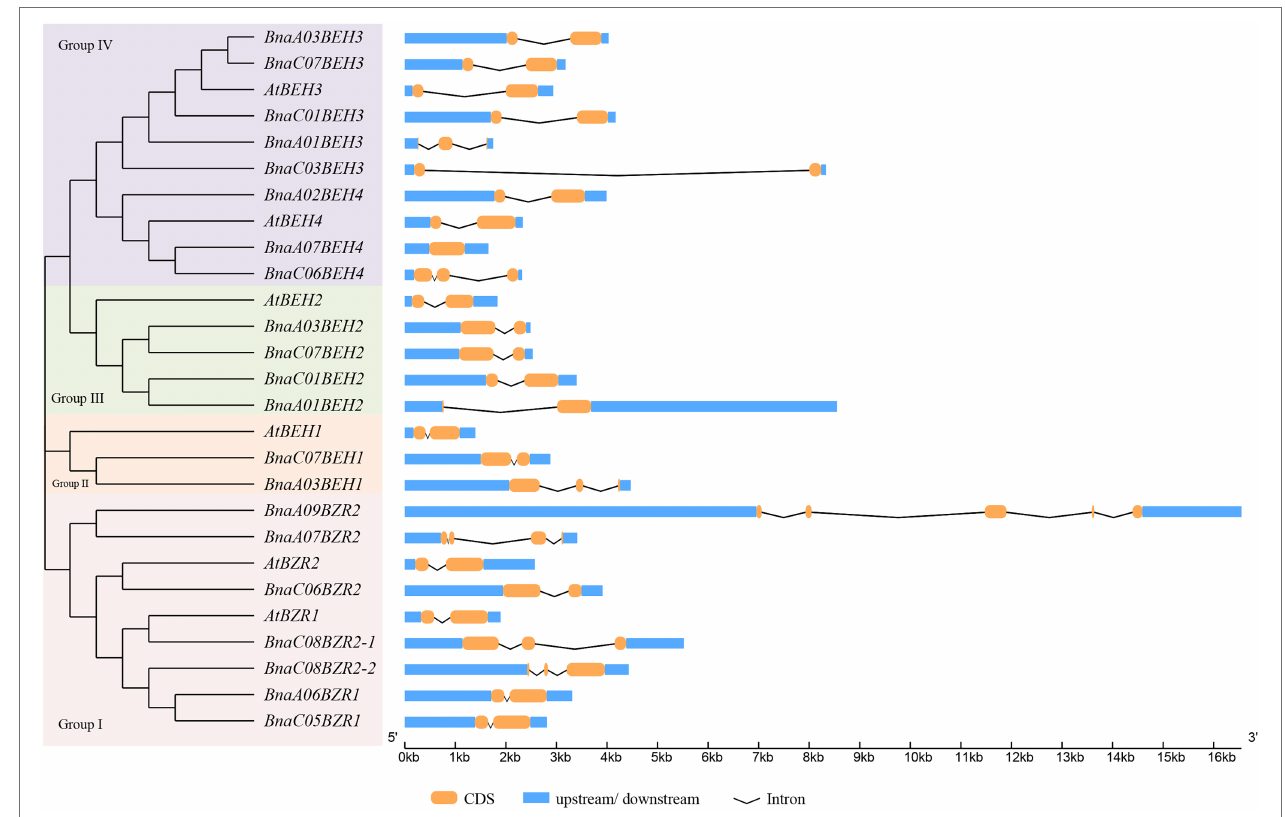
FIGURE 2 | Gene structure analysis of the B. napus and A. thaliana BZR gene family. Each BZR gene subfamily indicated as different color in Y -axis, while the X -axis represented the lengths of the exons and